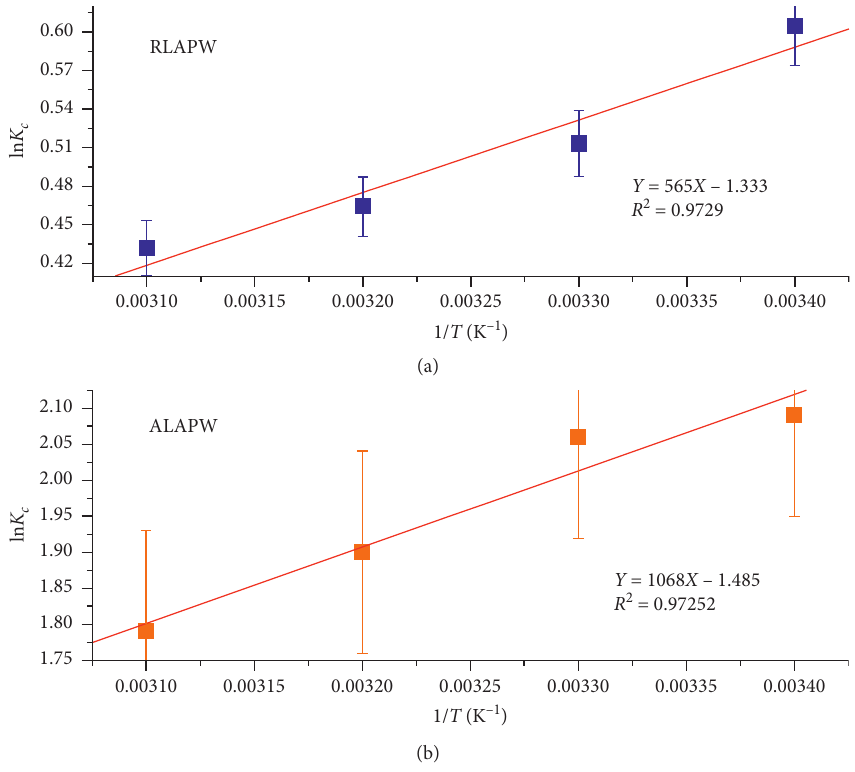
Figure 9: Plots of lnKc vs. 1/ T for the estimation of thermodynamic parameters.